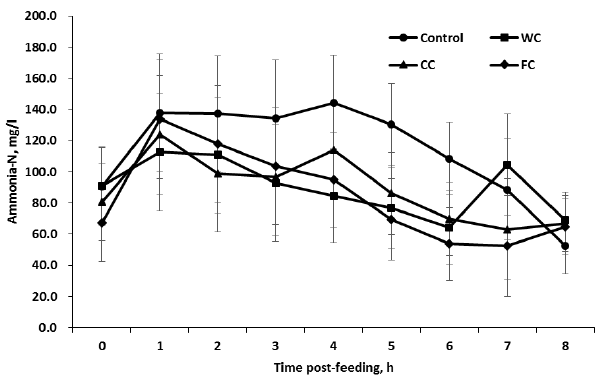
Figure 2 . Changes in ruminal pH of Holstein steers fed total mixed ration (TMR) as a basal. Treatments 380 Figure 2. Changes in ruminal pH of Holstein steers fed total mixed ration (TMR) as a were TMR only (Control, ●), TMR with whole corn grain (WC, ■), TMR with coarsely gro und corn grain 381 basal. Treatments were TMR only (Control, ● ), TMR with whole corn grain (WC, ■ ), (CC, ▲) , and TMR with finely ground corn grain (FC, ◆ ), respectively. 382 TMR with coarsely ground corn grain (CC, ▲ ), and TMR with finely ground corn grain 383 (FC, ♦ ), respectively.